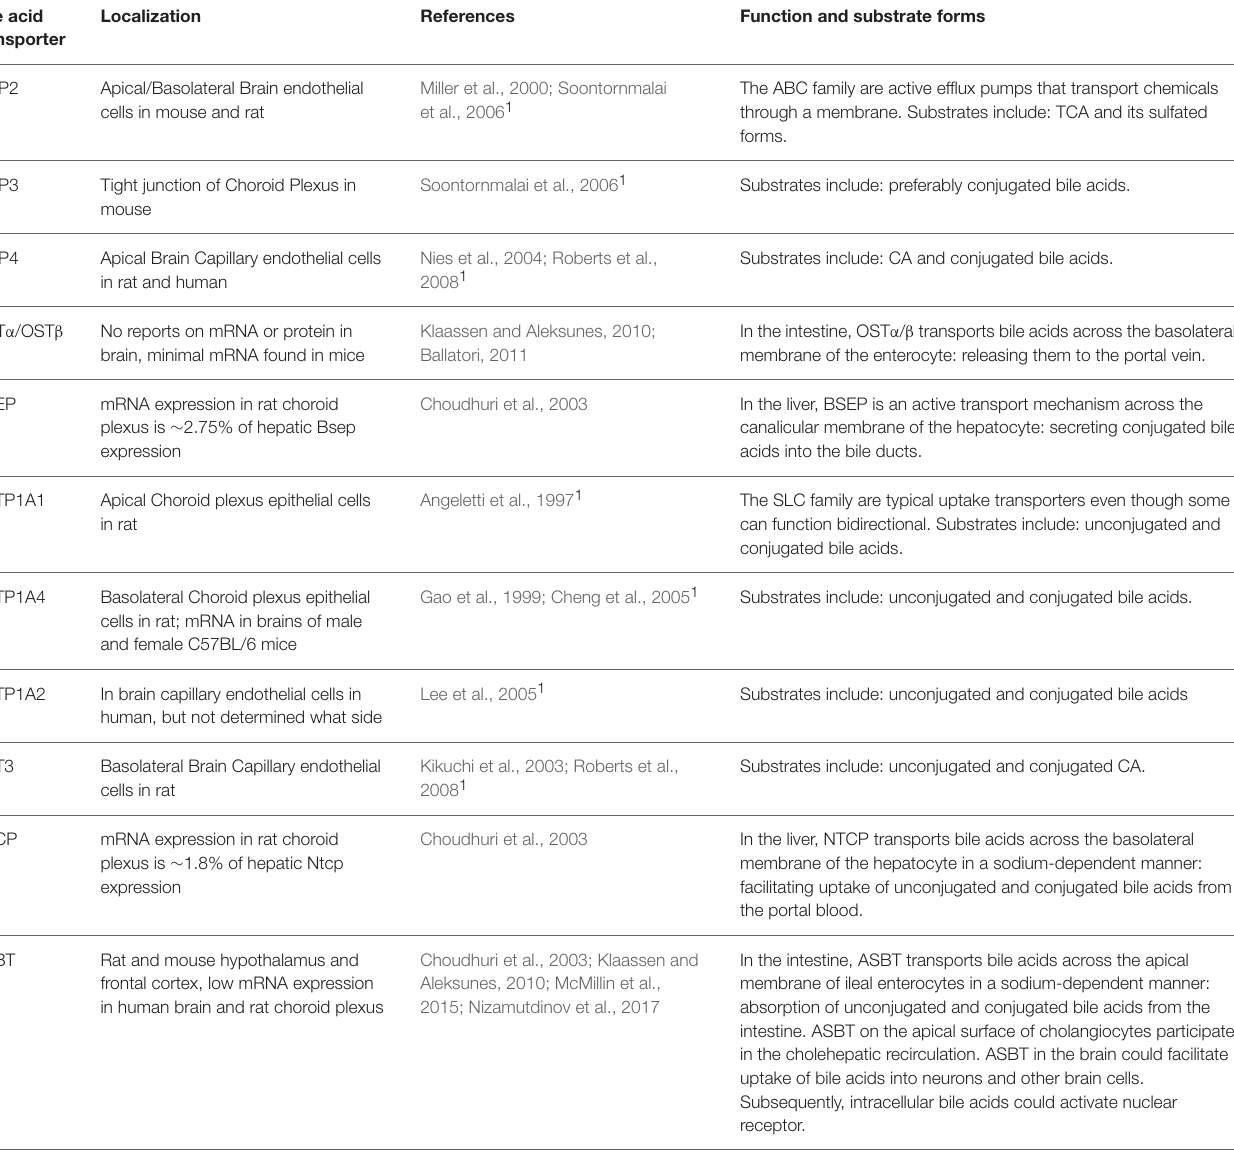
TABLE 1 | Bile acid transporters found in the